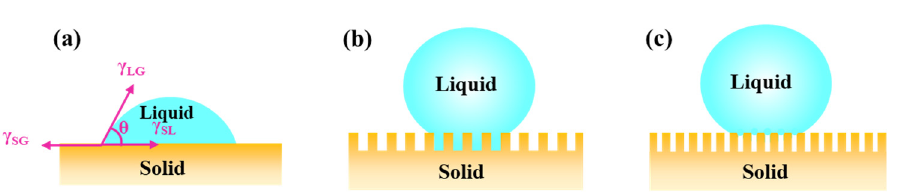
Figure 5. Schematics of wetting models: ( a ) Young model, ( b ) Wenzel model, ( c ) Cassie–Baxter model.